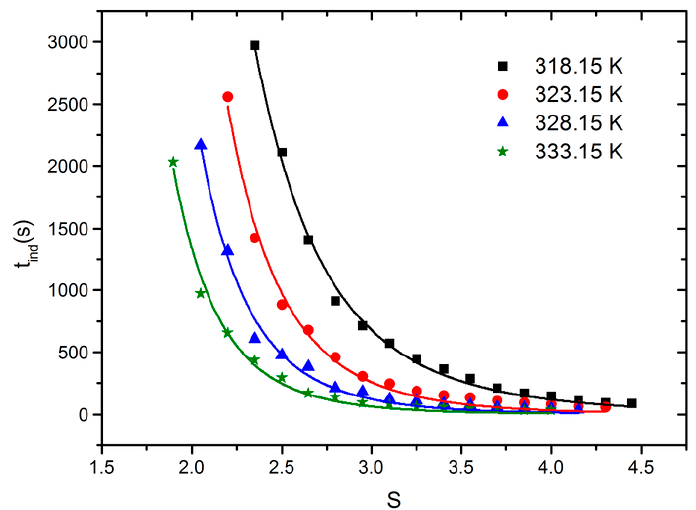
Figure 2. The nucleation induction times of Li 2 CO 3 at different temperatures and supersaturations.